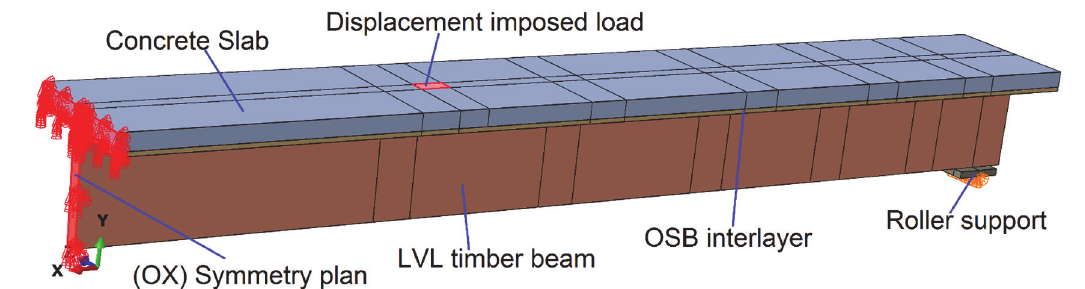
Figure 5: The modelled TCC beam with different components and boundary conditions.